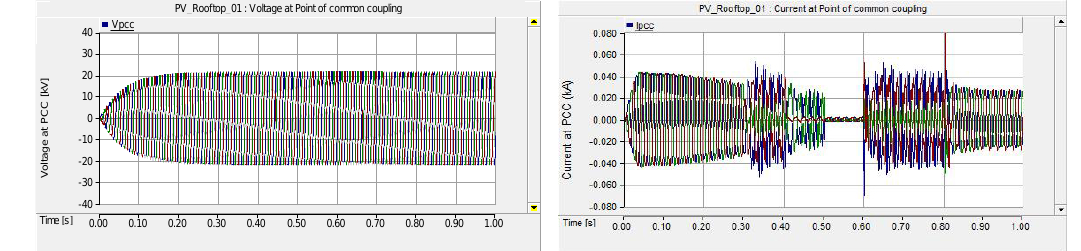
Figure 30. The voltage and current at the HV side of the distribution transformer.